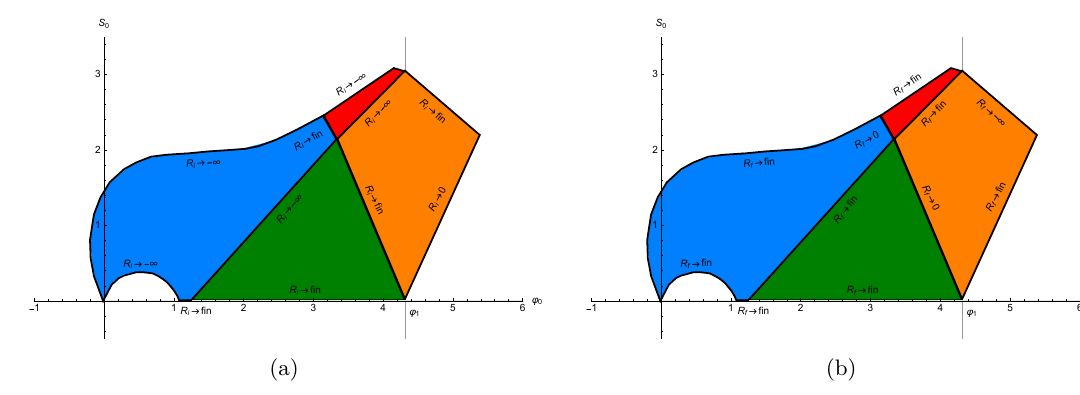
Figure 51 . (a) and (b): the behavior of R i and R f at